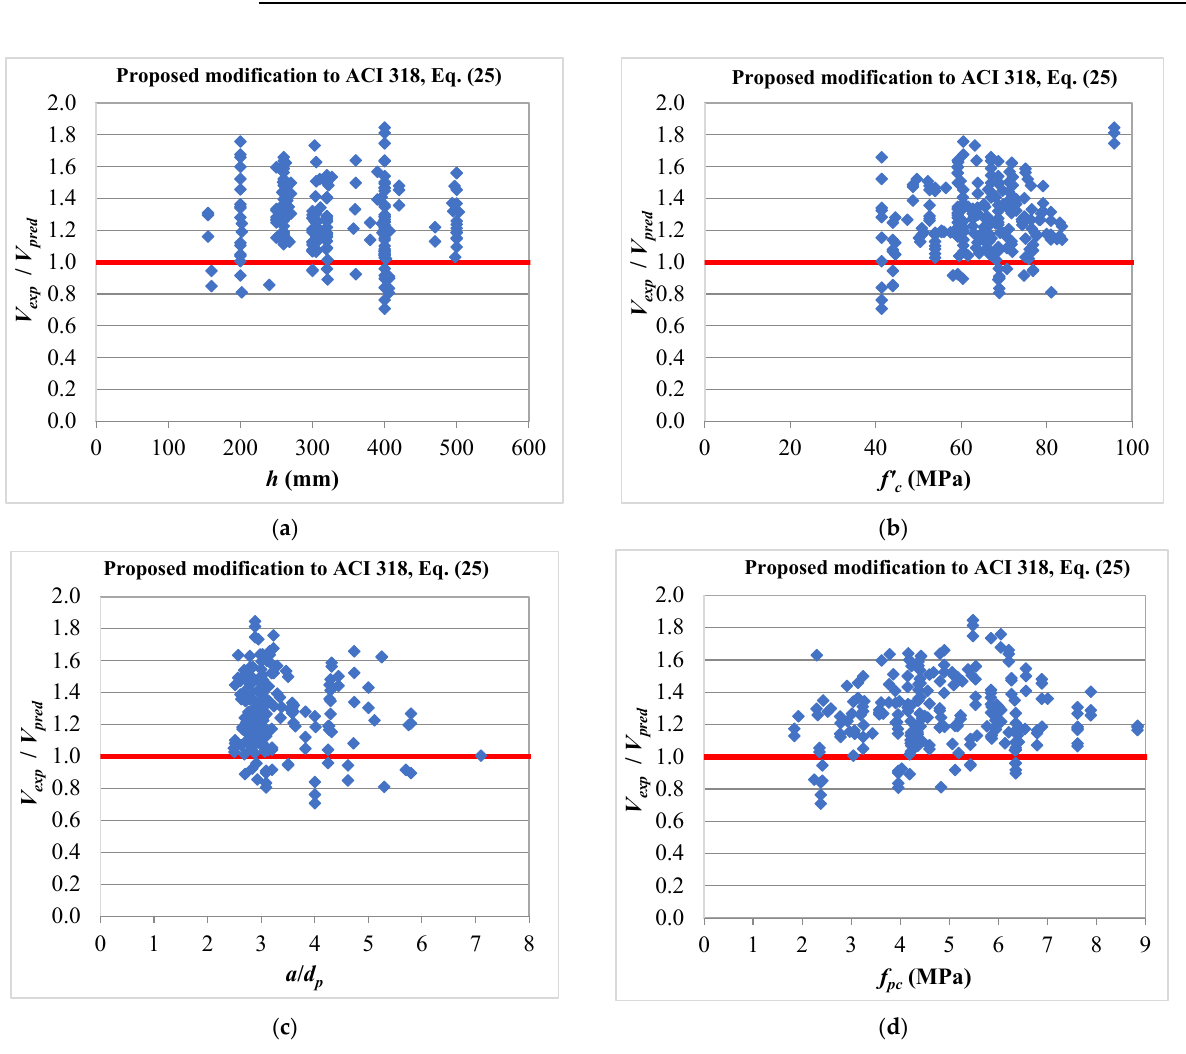
Figure 12. Predictions of Equation (25) against ( a ) total thickness, ( b ) concrete compressive strength, ( c ) shear span to depth ratio, and ( d ) compressive stress due to the fully effective prestressing force.